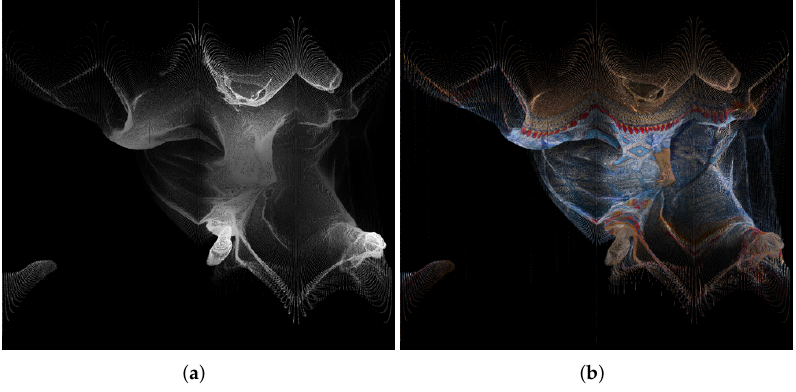
Figure 8. Panorama images created using point cloud “longdress_vox10_1060.ply” from the rectilin- ear projection, for the geometry ( a ) and texture ( b